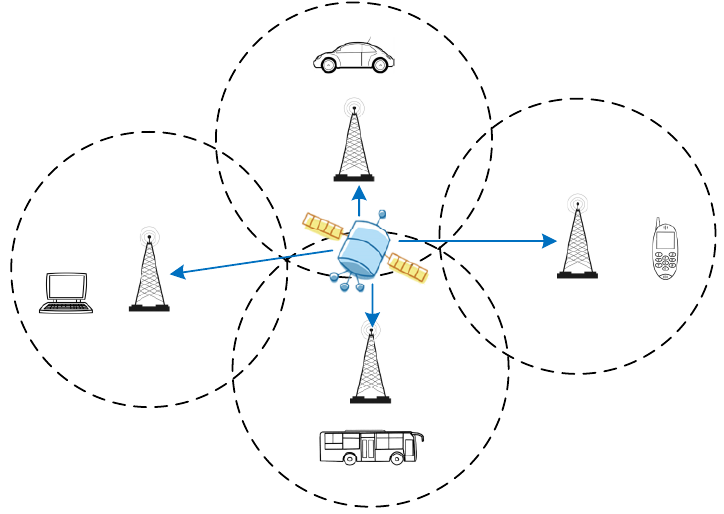
Figure 1. Terrestrial single frequency network coverage of the China mobile multimedia broadcasting (CMMB) system.